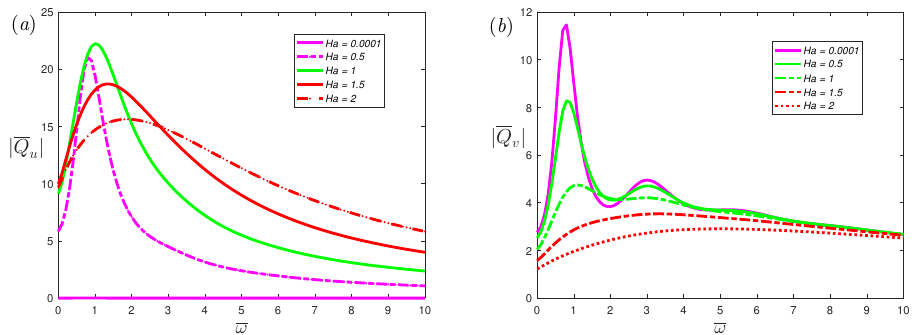
Figure 11. The dimensionless mean volumetric flow rate, ( a ) spanwise; ( b ) streamwise, of the fractional Maxwell model with the dimensionless frequency ω for different dimensionless parameters Ha at α = 0.7, β = 1, K = 20, De = 5, L =